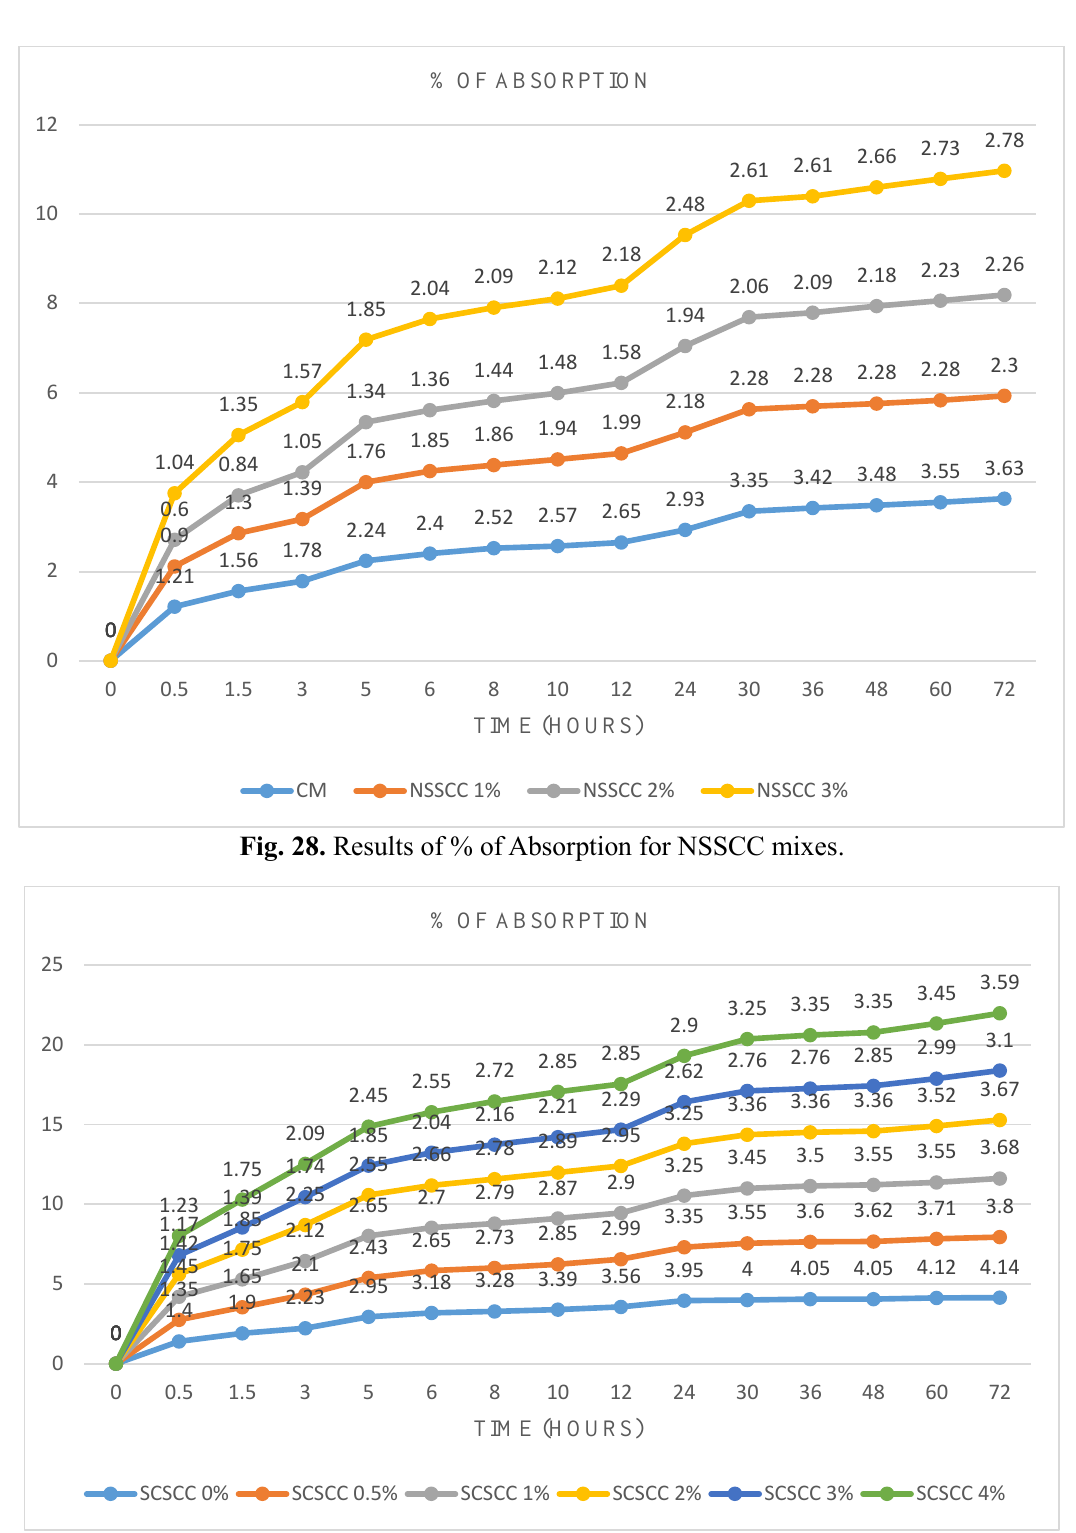
Fig. 29. Results of % of Absorption for SCSCC